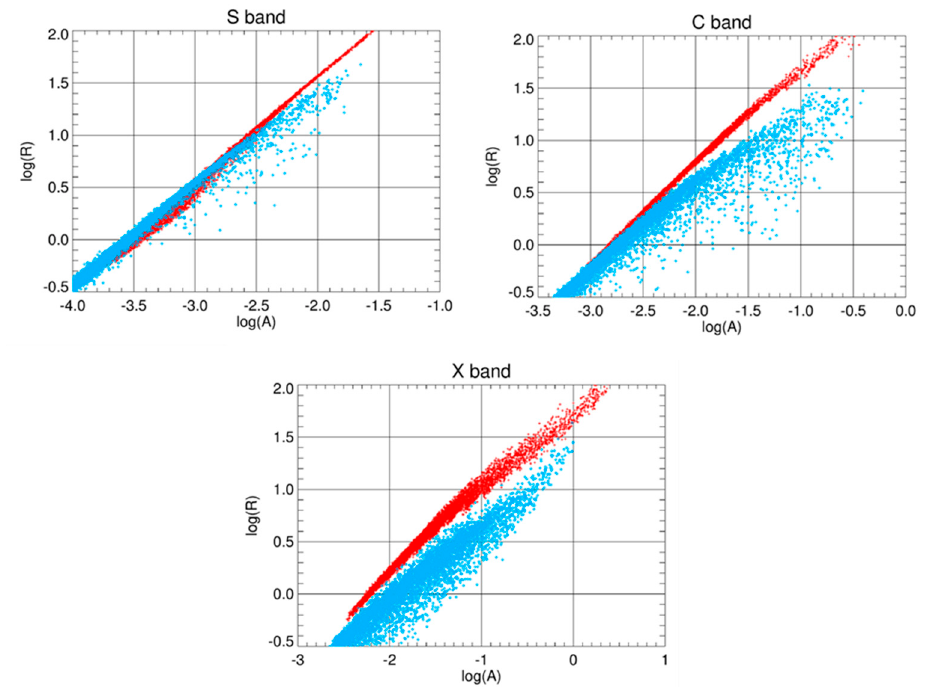
Figure 6. Scatterplots of log( R ) vs. log( A ) at S, C, and X bands for “very tropical” rain (red dots) and “very continental” rain (blue dots). Specific attenuation is computed for the temperature 20 °C.